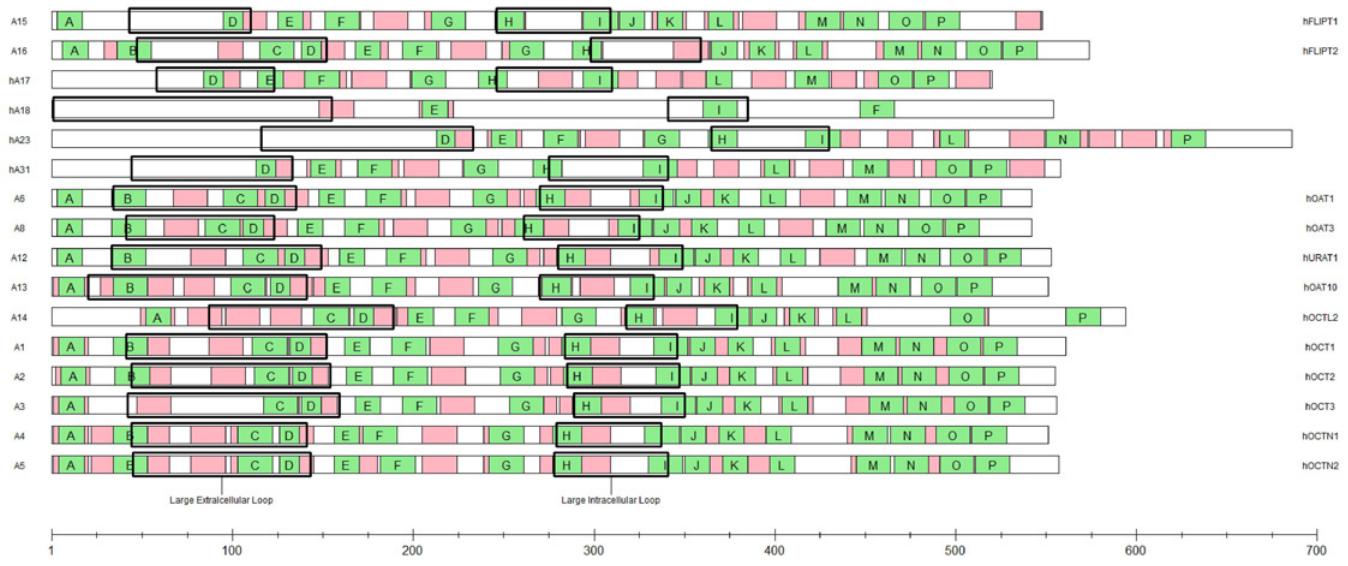
Fig 2. Shared Motifs of SLC22 Family Transporters by MEME Analysis on 16 of the Sequences Used in the Analysis. Abbreviations of the SLC22 member number is on the far left (e.g., A15 = SLC22A15) and known common names are on the far right. In green are the SLC22 family-conserved motifs which are lettered (A-P) in the order that they appear in the SLC22A6 amino acid sequence. The majority of the sequences follow this motif order. In red are the subclade-specific motifs overlaid on the same 1D representation of each SLC22 sequence. The first box labeled the Large Extracellular Loop represents the predicted Large Extracellular Loop [56] and the second box labeled the Large Intracellular Loop represents the predicted Large Intracellular Loop. Note that each 1D representation is proportionally scaled such that each sequence length can be estimated in the scale near the bottom of the